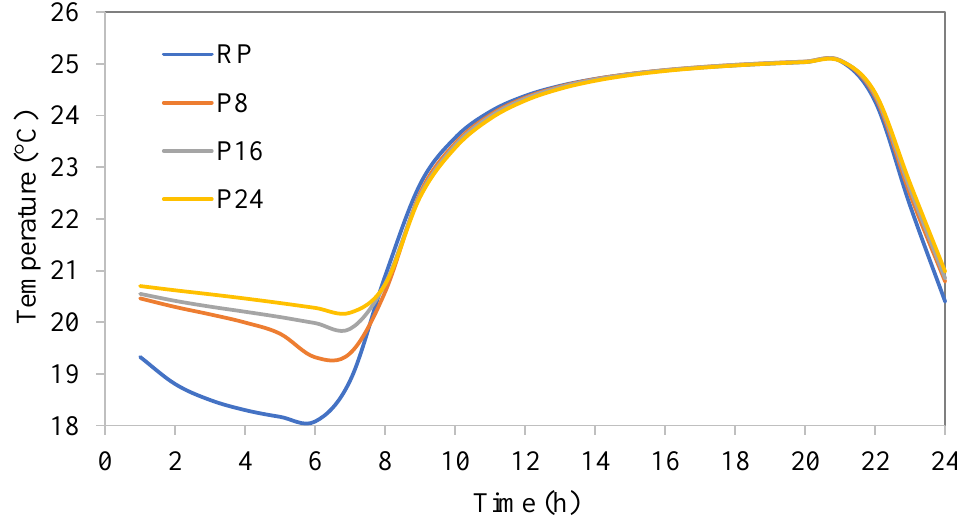
Figure 9. Distribution of interior surface temperatures of studied plasters during summer in Prague.